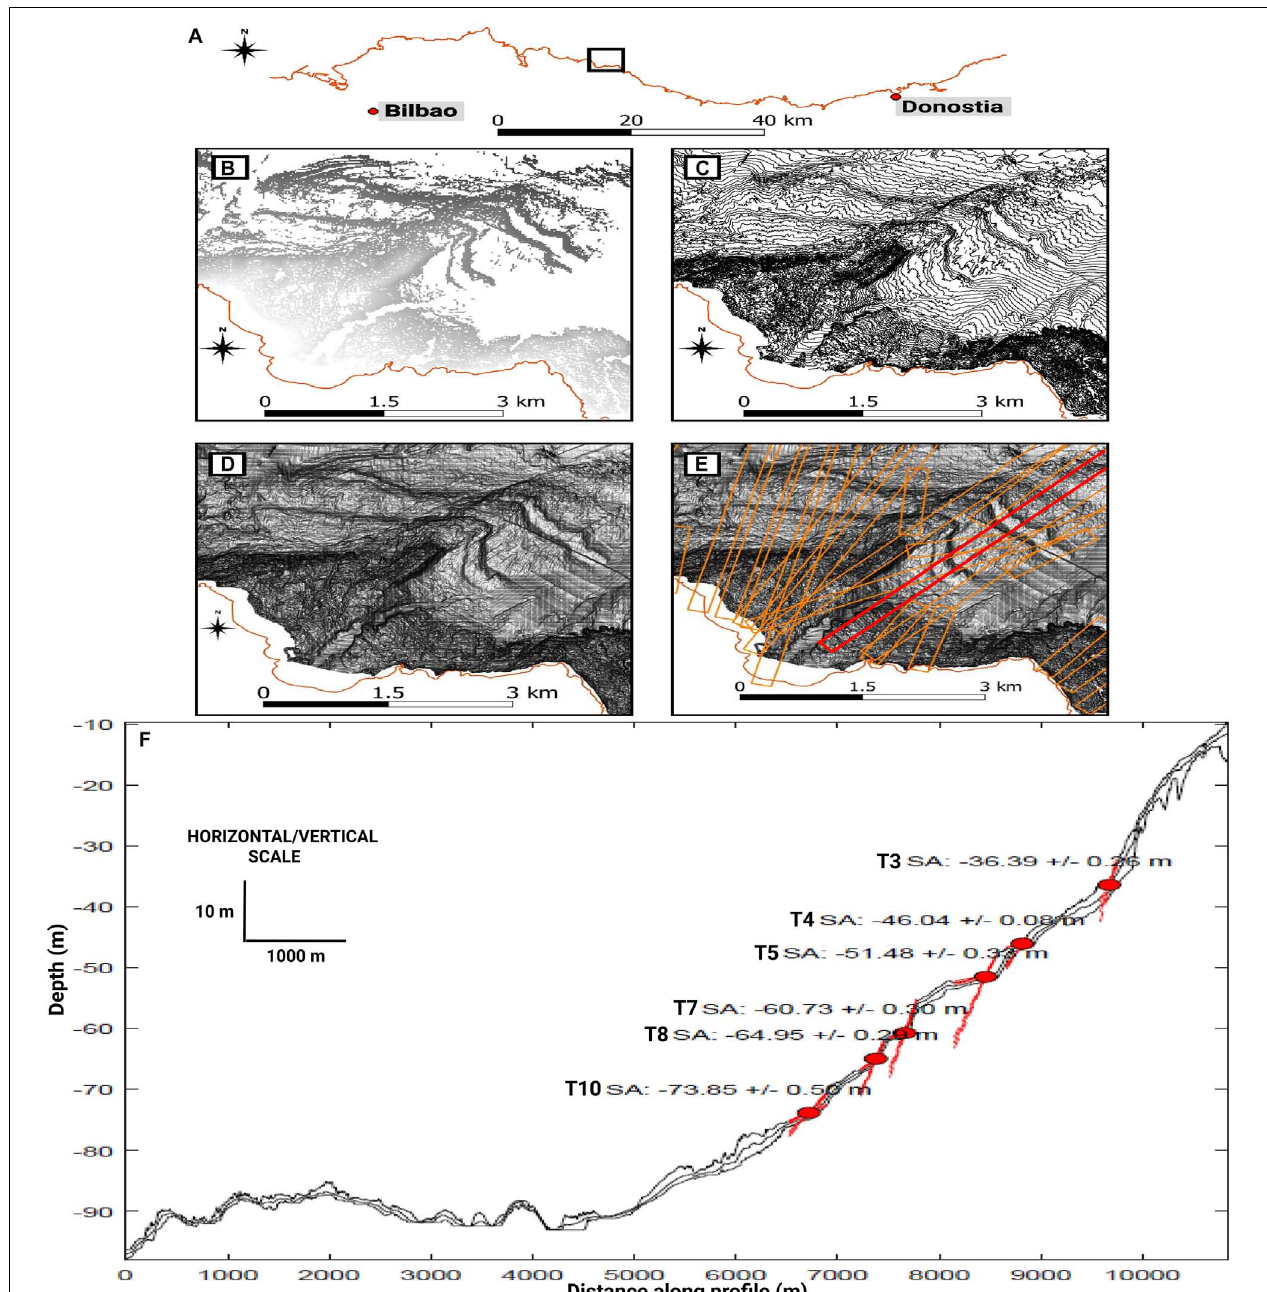
FIGURE 3 | Submerged fossil sea-cliffs detection and shoreline angle mapping. (A) Study area coastline, the black box highlights the area detailed in the next figures. (B) Surface Classification Model map. (C) Contour map. (D) Hillshaded map. (E) Bathymetric swath profiles. The red swath profile is represented in (F) . Bathymetric swath profile with shoreline angles (SA) and associated marine